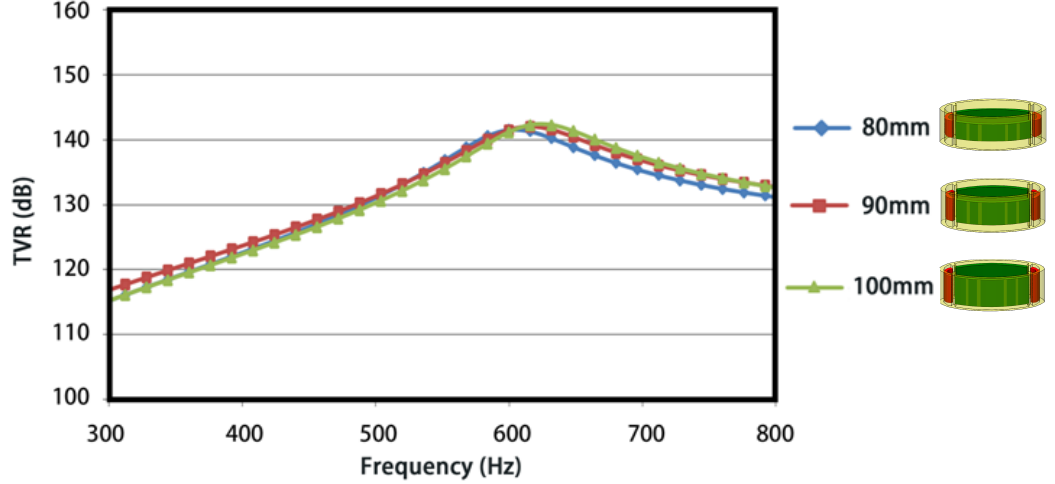
Figure 13. Influence of the driver stacks height on the TVR.